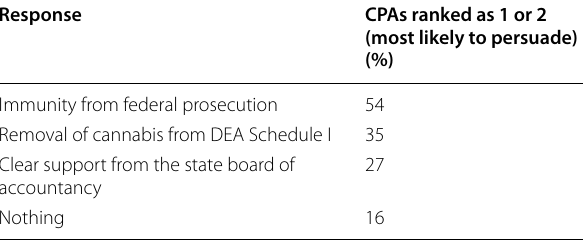
Table 2 Motivations for CPAs to serve the cannabis industry reported by survey